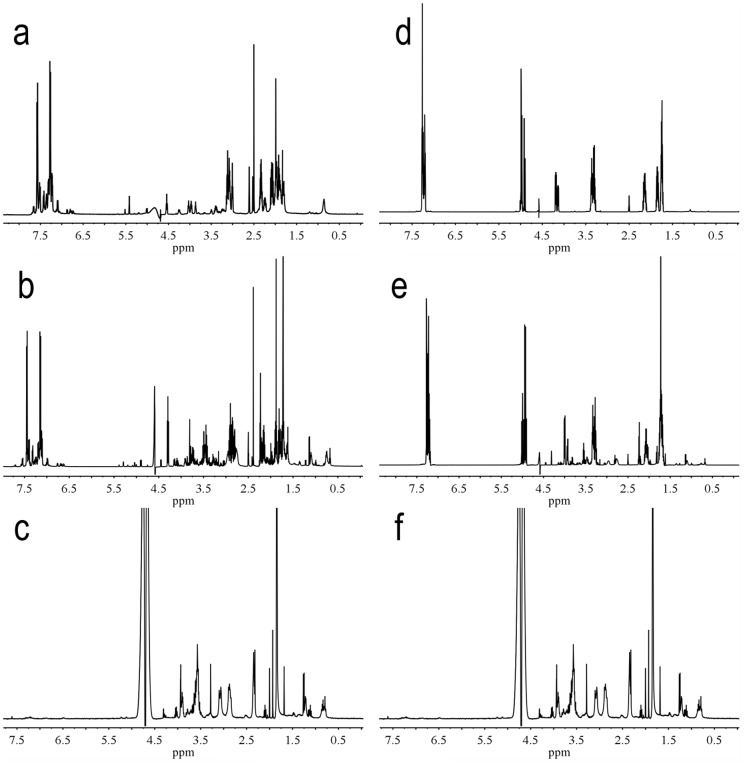
NMR spectra of PA1 and b PA2.
a, d PA1, PA2 in D2O. b, e PA1, PA2 in reaction mixture. c, f Reaction mixture (100 µL, containing 14 µg PHD3, 1.0 mM DTT, 2.0 mM ascorbate, 50 µM FeSO4, 0.16 mM 2-oxoglutarate, 2.0 mg/mL BSA, 0.60 mg/mL catalase, and 66.55 µM HIF-1α peptide in 20 mM phosphate buffer (pH 7.0)).